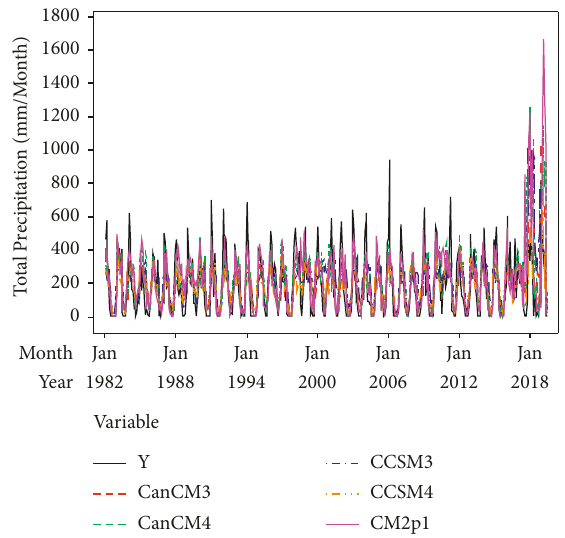
Figure 3: Time series plot between ensemble prediction and rainfall